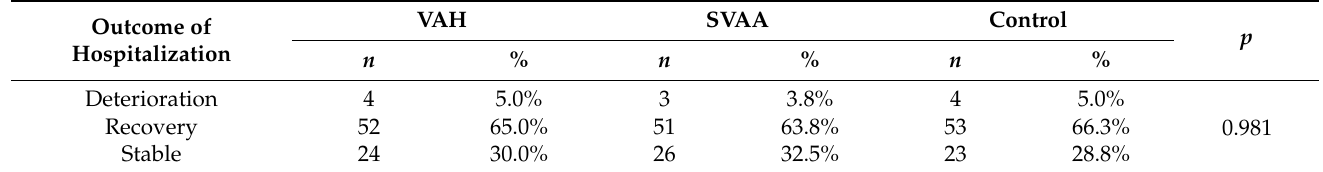
Table 6. Outcome of